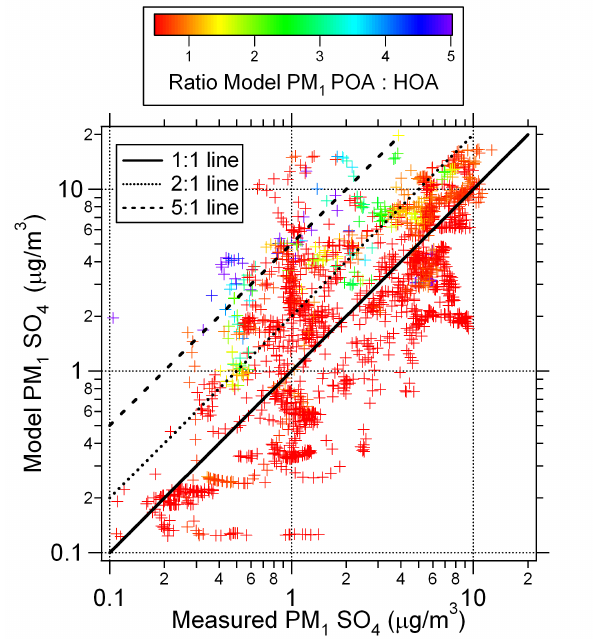
Fig. 6. Correlation of modeled SO 4 and measured SO 4 at Harrow, coloured-coded as a function of the ratio of model POA to HOA, for the period from 19 June to 10 July